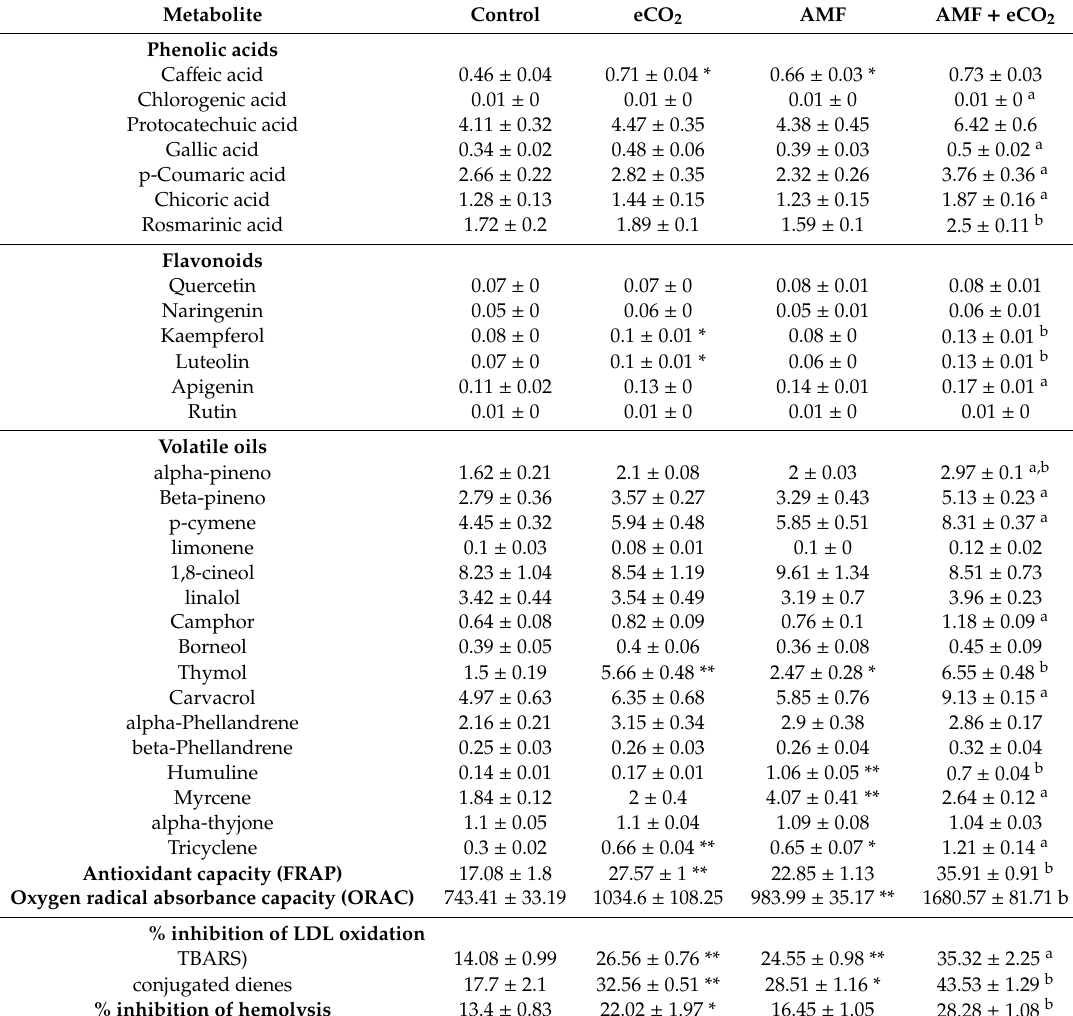
Table 3. Levels of phenolic compounds and volatile oils (mg g − 1 dry weight) and biological activities in Thymus vulgare grown under normal conditions (control) or the e ff ect of eCO 2 (620 ppm), AMF or their combination (AMF-eCO 2 ). Values are mean ± standard error of five independent replicates. Asterisks indicate significant changes (* p < 0.05; ** p < 0.01) compared to control, as revealed by Student’s t-test. Lowercase letters indicate significant di ff erences ( a p < 0.05; b p < 0.01) between AMF alone and the combined AMF + eCO 2